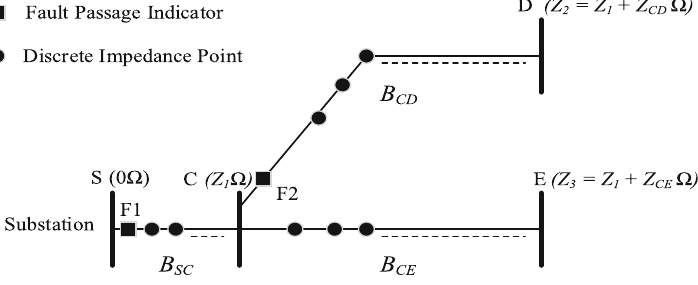
Fig. 4 Generalized 4 bus radial